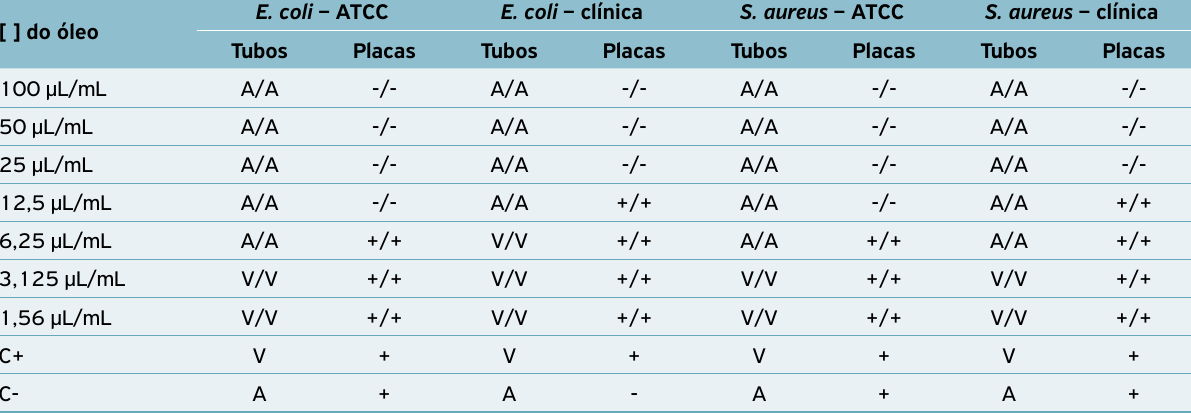
Tabela 1. Resultados do teste da atividade antimicrobiana do óleo essencial de orégano pela técnica de macrodiluição sobre amostras padrão (ATCC 25922 e 25923) e clínicas de Escherichia coli e Staphylococcus aureus .